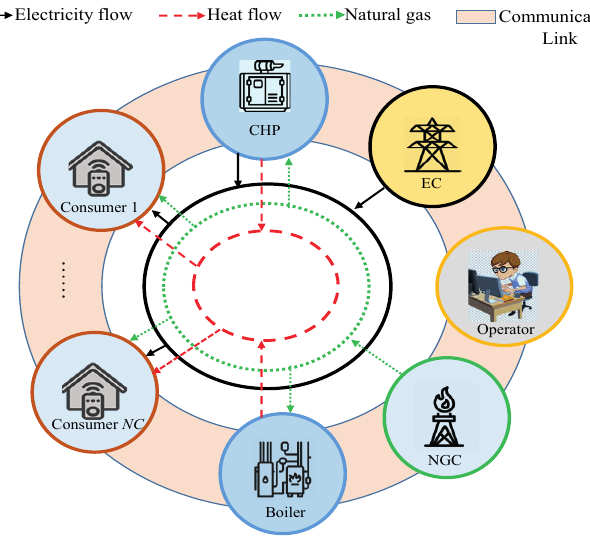
Fig. 1. Smart multiple energy system